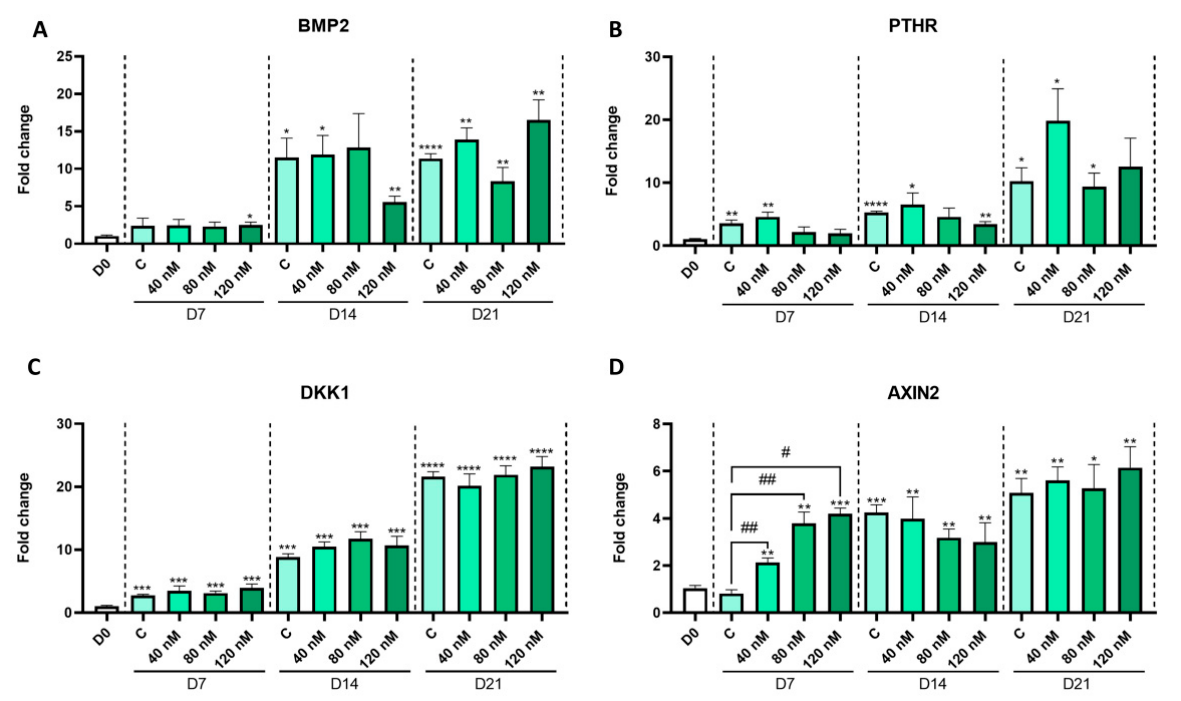
Figure 3. Relative expression levels of BMP2 ( A ), PTHR ( B ), and Wnt signaling-related genes ( C , D ) in ATDC5 cells throughout the 21 days of differentiation with or without MPH (40, 80, and 120 nM) (n = 3). BMP: Bone Morphogenetic Protein 2; PTHR: Parathyroid Hormone 1 Receptor; DKK1: Dickkopf WNT Signaling Pathway Inhibitor; AXIN2: Axis Inhibition Protein 2. Bars represent means with SEM (n = 3). *: statistically different vs. day 0 ( p < 0.05); **: p < 0.01; ***: p < 0.001; ****: p < 0.0001; #: statistically different vs. untreated control from the same day ( p < 0.05); ##: p < 0.01.